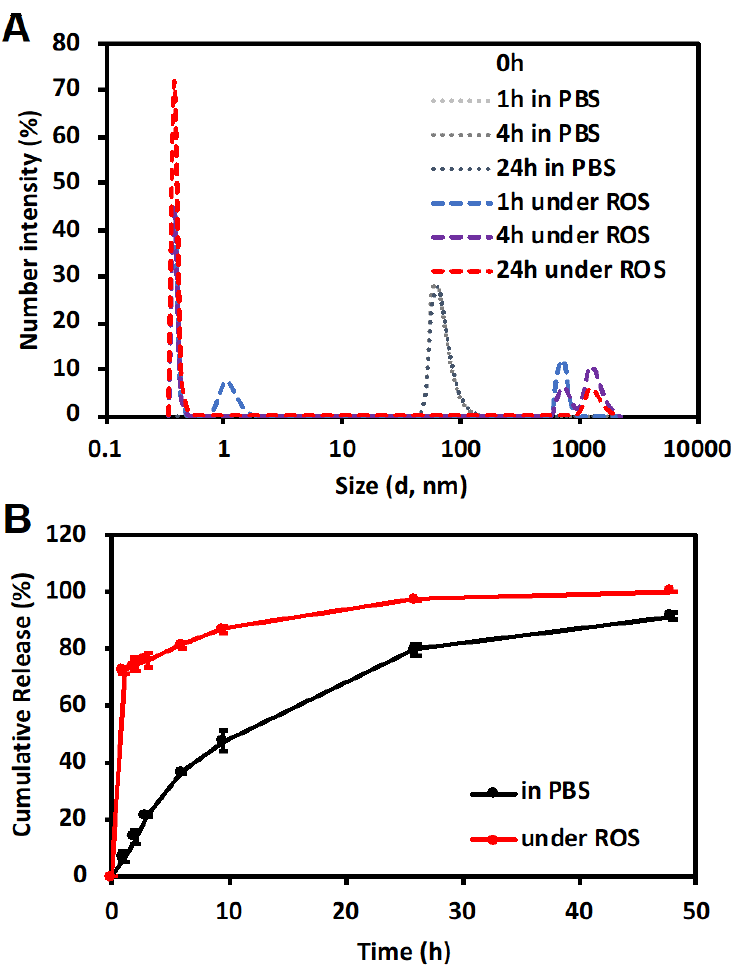
Figure 5. ROS responsiveness. ( A ) DLS of MMAF@BBN-PEG-PPADT before and after ROS exposure. ( B ) Drug-release behavior of MMAF@BBN-PEG-PPADT in PBS or under ROS.